Question: Describe this figure in one sentence.
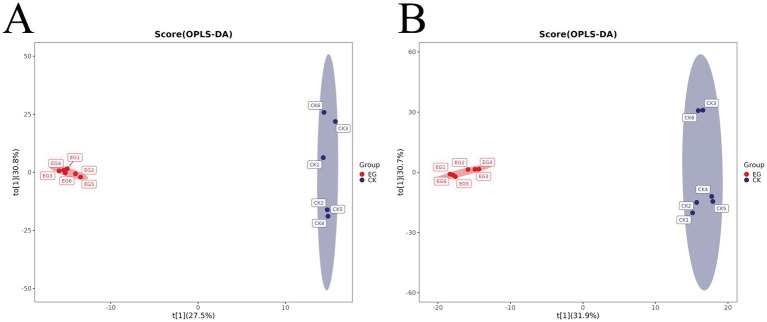
Answer: OPLS-DA score plots in positive ion and negative ion modes. (A) Positive ion modes; (B) Negative ion modes.